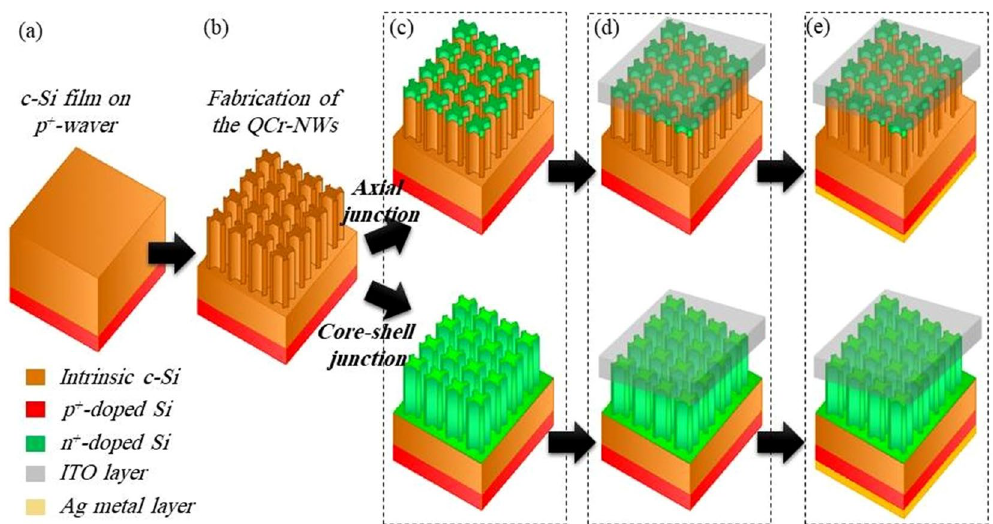
Figure 19. Fabrication steps proposed for the informed QCr-NW structure. This image is created by Lumerical 2020a, FDTD Solver Version 8.23.2305, https:// www. lumer ical. com (license number-12802) released to Zewail City of Science and Technology, Giza,